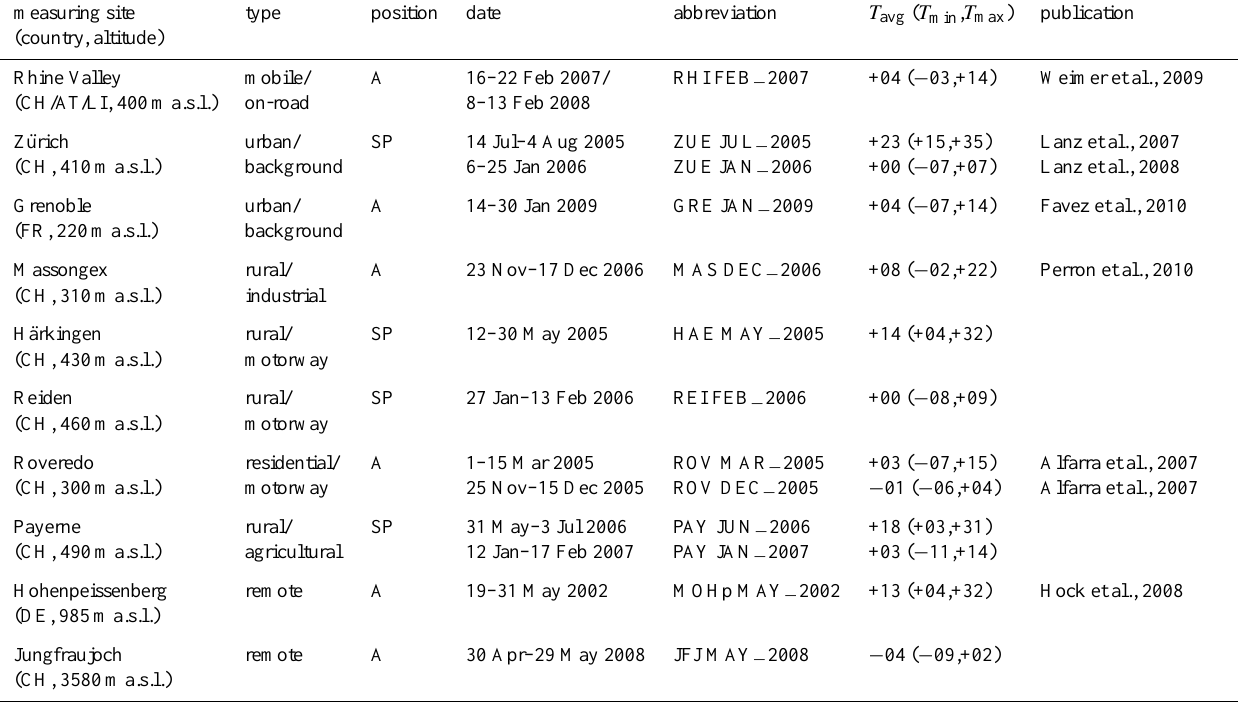
Table 1. Sampling sites, altitude (meters above sea level,ma.s.l.), type and position of the site (A=Alpine region, SP=Swiss Plateau), duration of the AMS field campaigns, abbreviation, and ambient temperature (in ◦ C), as well as related publications. Quadrupole aerosol mass spectrometers (Q-AMS) were deployed in all campaigns with the exceptions of Jungfraujoch and Grenoble, where time-of-flight mass spectrometers (ToF-AMS) were used. (Country codes: CH=Switzerland, AT=Austria, LI=Liechtenstein, DE=Germany, FR=France). measuring site type